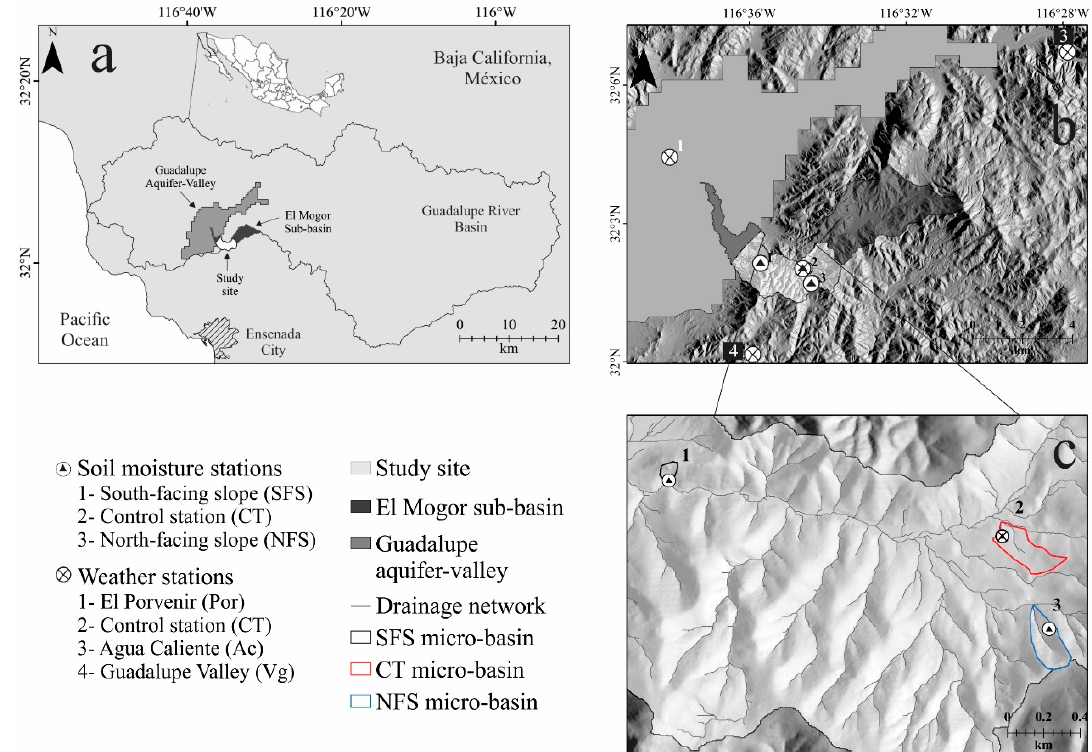
Figure 1. ( a ) Location of the study site in Baja California, Mexico. ( b ) Shaded relief map, with monitoring sites and surrounding weather stations shown. ( c ) South-facing slope (SFS), control (CT) and north-facing slope (NFS) micro-basins are presented.